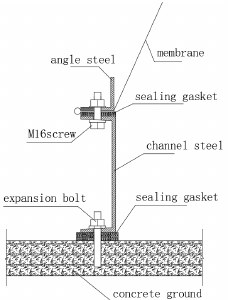
Buildings 2023 , 13 , x FOR PEER REVIEW Figure 13. Membrane installation. Figure 13. Membrane installation.